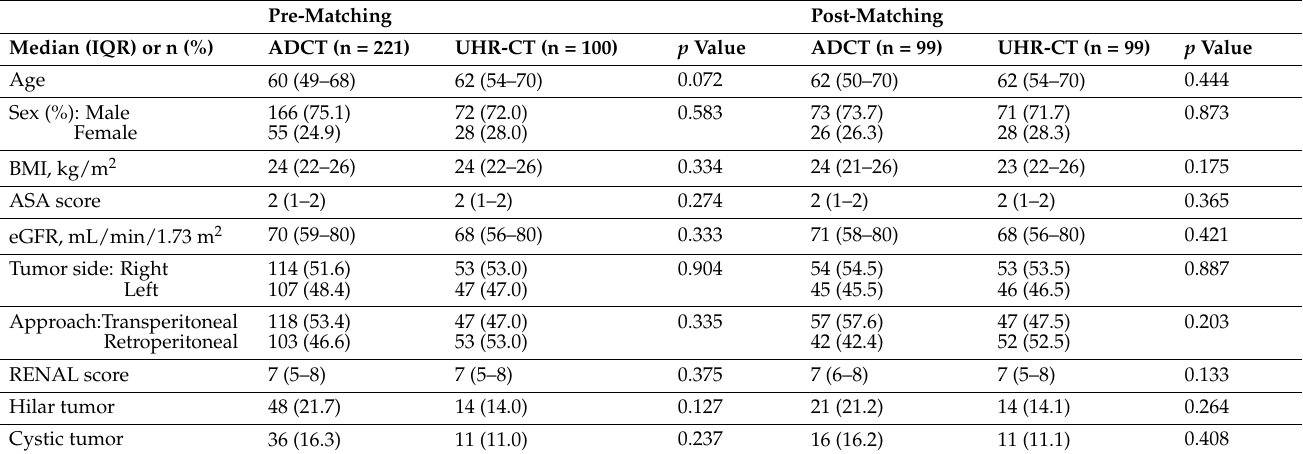
Table 1. Patients’ clinical